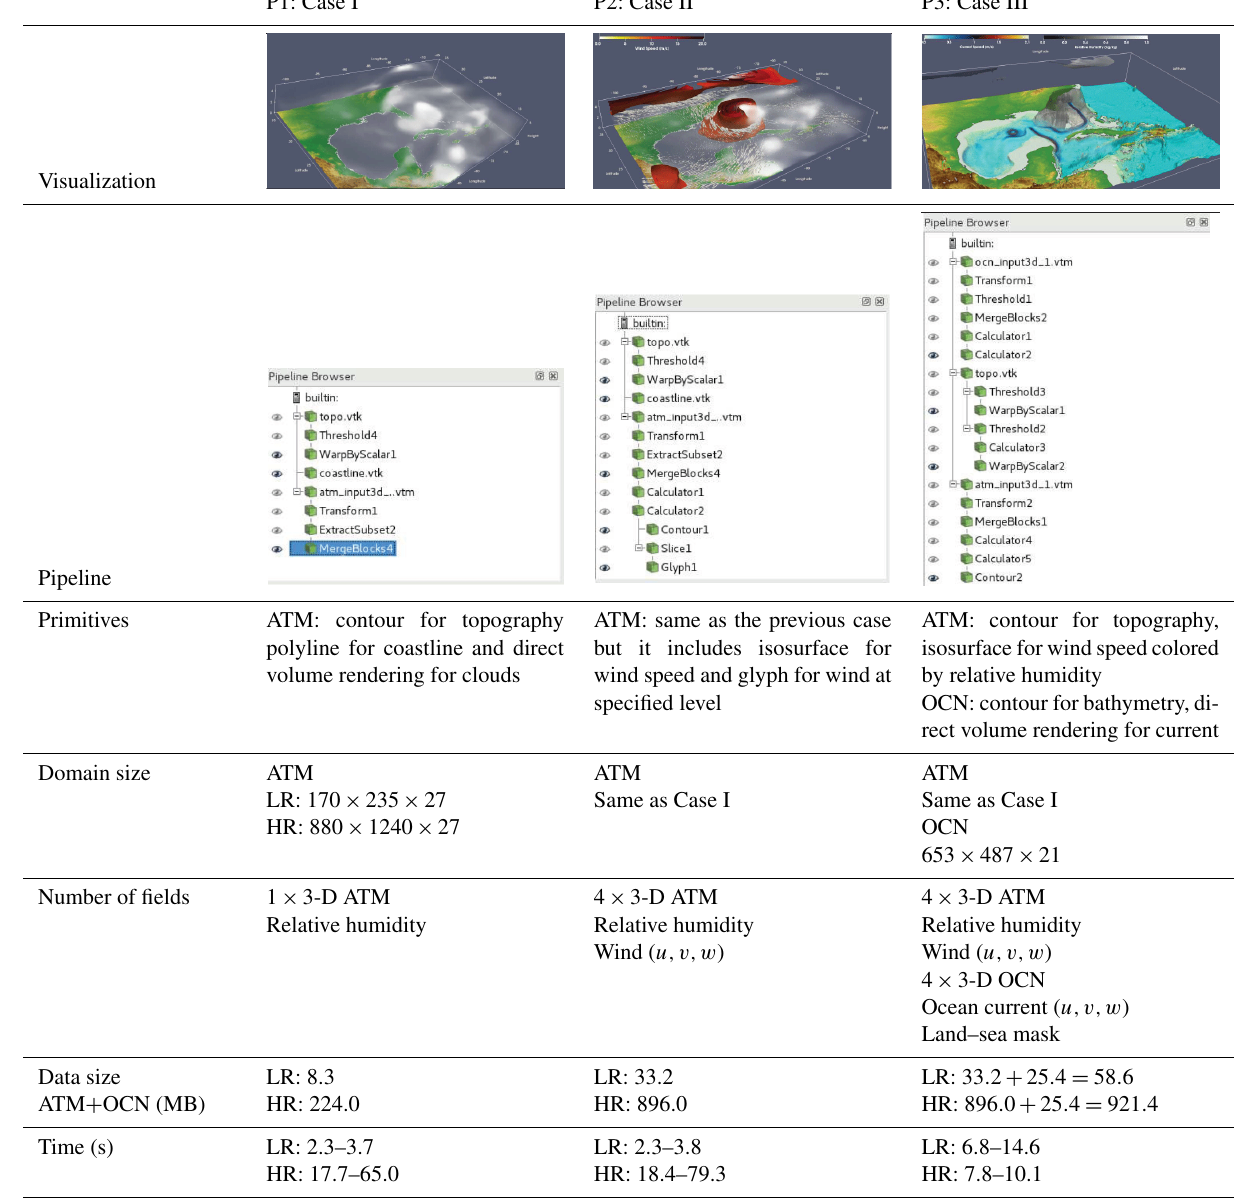
Table 1. Tested model configurations for benchmark simulations. Note that the dimensions of vertical coordinates of ATM and OCN compo- nents are shown here after vertical interpolation from sigma to height and s coordinates to depth. The visualization pipelines are also given in the